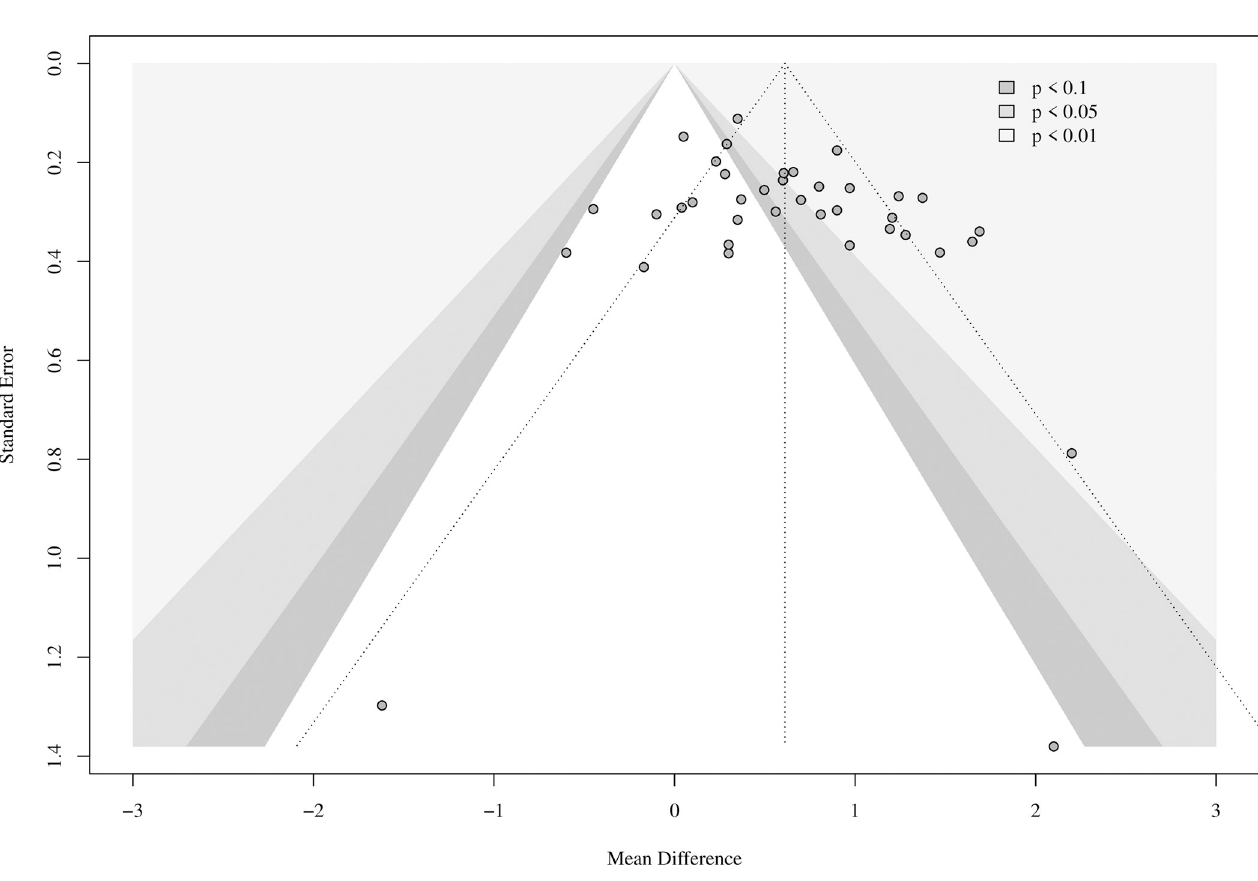
Fig 8. Funnel plot of published